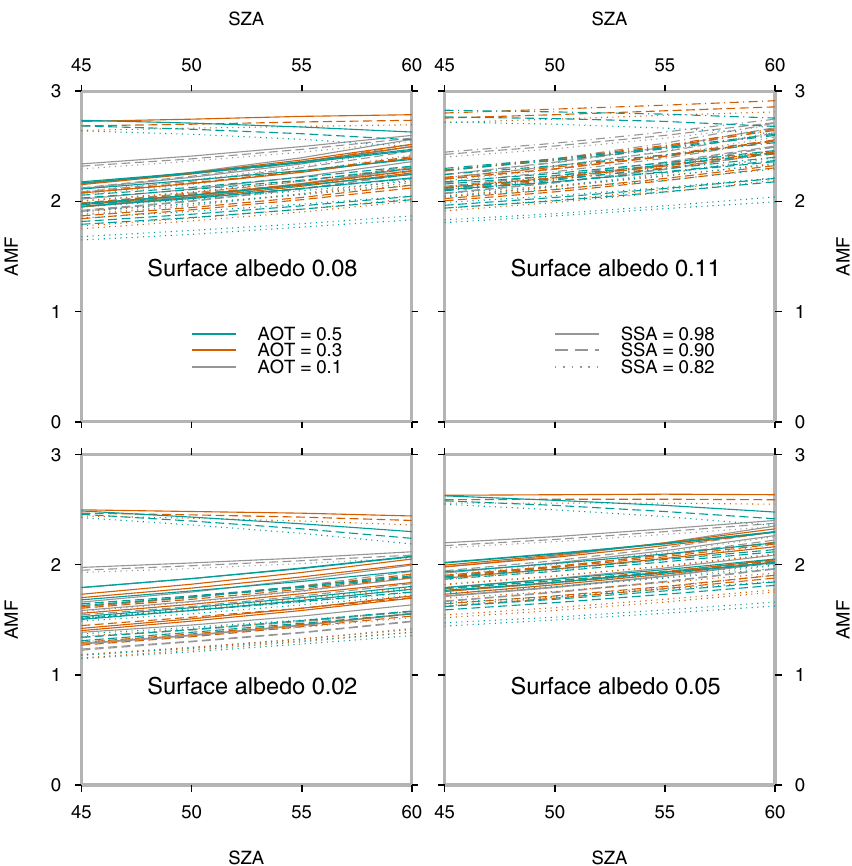
Figure 6. Calculated air-mass factors from the six high surface elevation (1400m) scenarios outlined in Fig. 4, plotted as a function of solar zenith angle and surface albedo. A dotted line indicates ω = 0 . 82, a dashed line ω = 0 . 90, and a solid line ω = 0 . 98. AOT is indicated by line colour: grey for AOT = 0.1, orange for AOT = 0.3, and blue-green for AOT = 0.5. At all surface albedos, the three upper curve families which stand out from the pack originate from Scenario